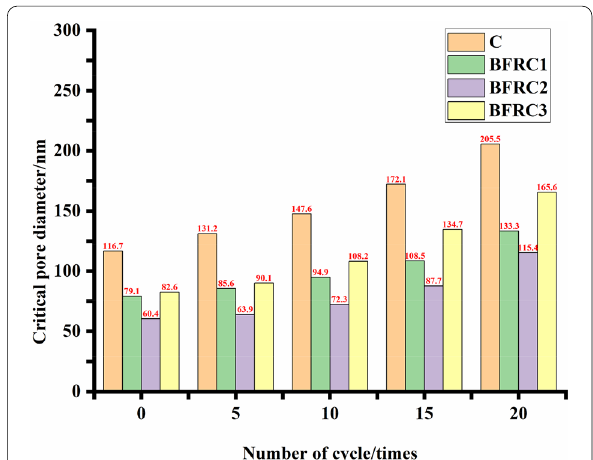
Fig. 16 The critical pore diameter of concrete at different single-side salt-freezing–drying–wetting